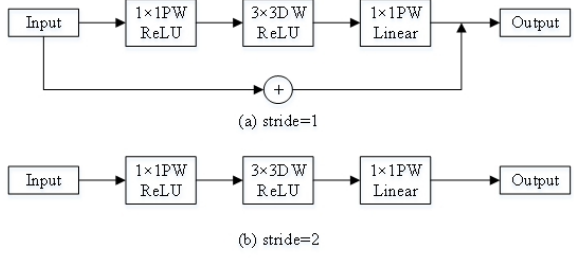
Fig. 1. MobileNetV2 bottleneck